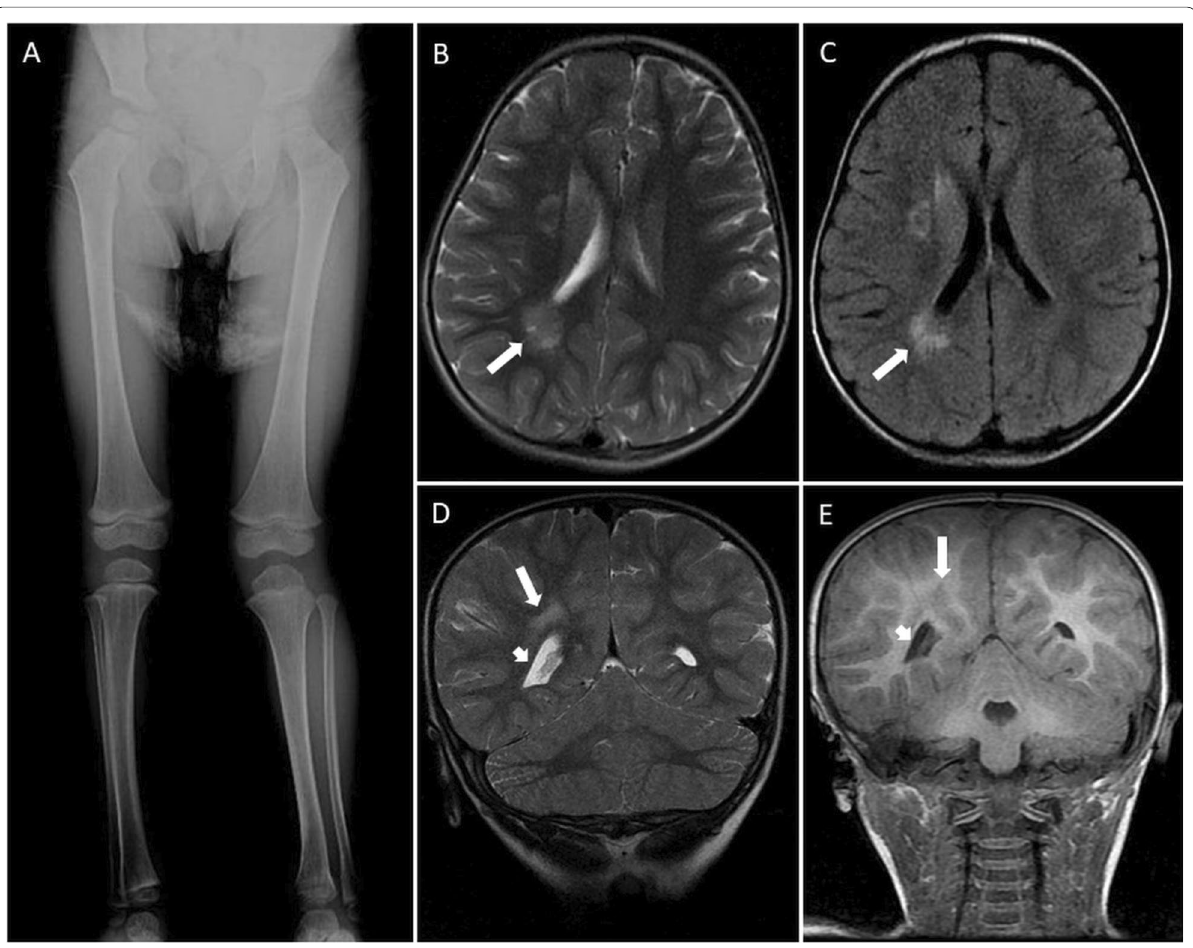
Fig. 2 MR images of a 2-year-old female mild hemimegalencephaly in the right cerebral hemisphere with hypomelanosis of Ito. ( a ) Direct X-ray of the lower extremity shows hemihypertrophy in the left lower extremity. ( b ) axial T2-weighted; ( c ) axial FLAIR; ( d ) coronal T2-weighted series show amorphous, hyperintense white matter lesions extending from the basal ganglia to the ventricular body and the periventricular fronto-parieto-occipital white matter (thick arrows). ( e ) Coronal 3D spoiled gradient-recalled (SPGR) T1-weighted series shows isointense lesions (thick arrows) with grey matter in periventricular white matter areas in the right basal ganglia-corona radiata plane and dilatation of the lateral ventricle